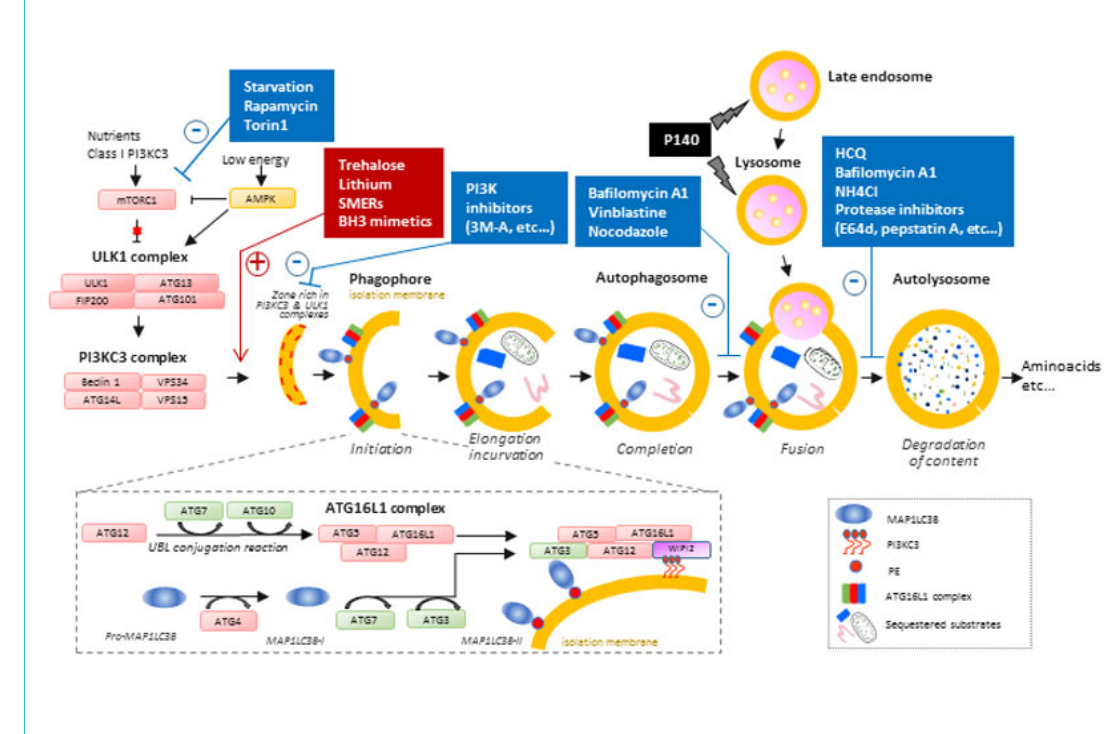
Figure 3: Simplified scheme showing the process of macroautophagy and a partial list of known enhancers and inhibitors that can affect au- tophagic activity.Abbreviations not defined in the text: ATG = autophagy related; 3-MA = 3-methyladenine; PE = phosphatidylethanolamine; MAP1LC3B = microtubule-associated proteins 1A/1B light chain 3B; PI3K = phosphoinositide 3-kinase; SMER = small-molecule enhancers; UBL = ubiquitin-like; VPs = vacuolar protein